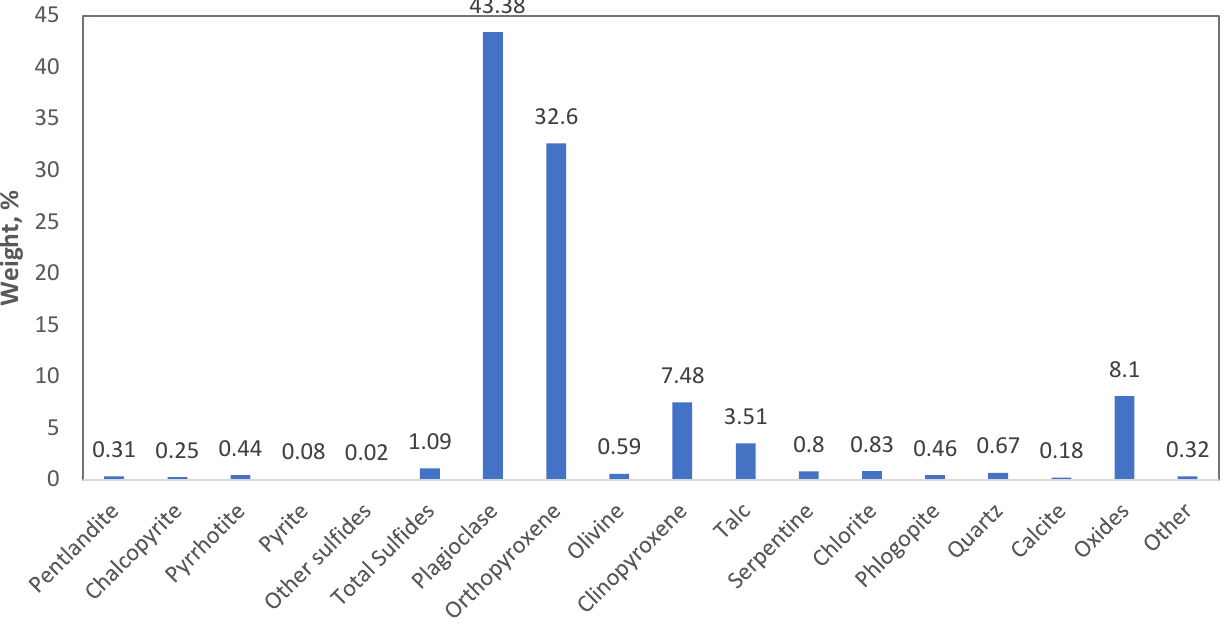
Figure 1. QEMSCAN modal composition of sulfides and gangue minerals of the selected Merensky ore.